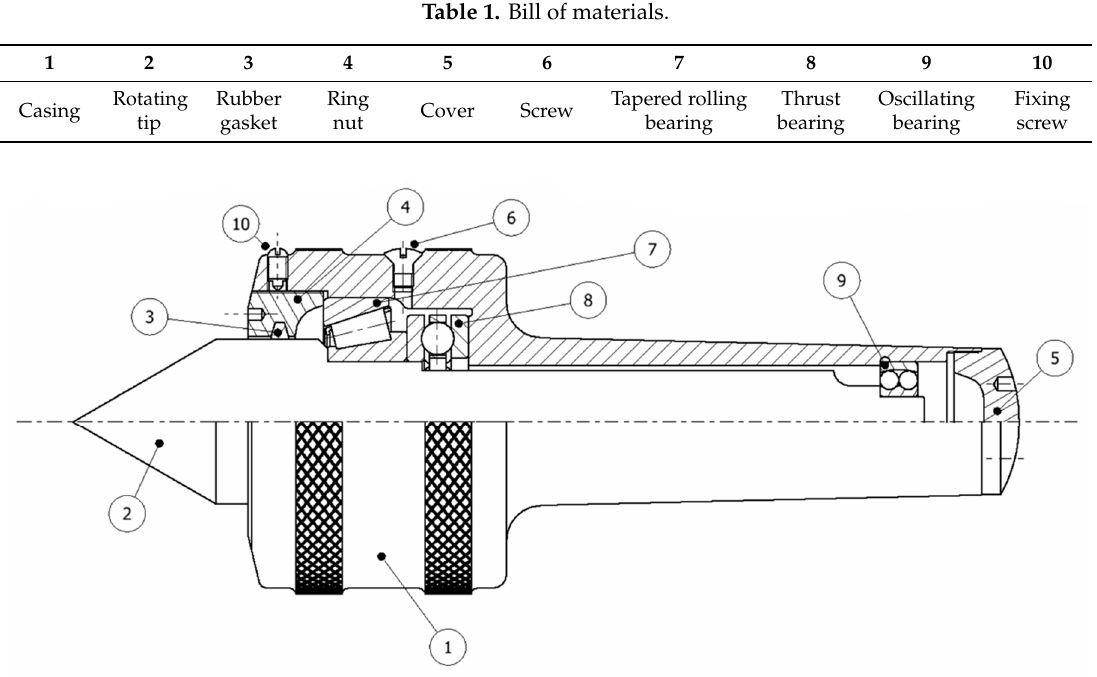
Table 1. Bill of materials.